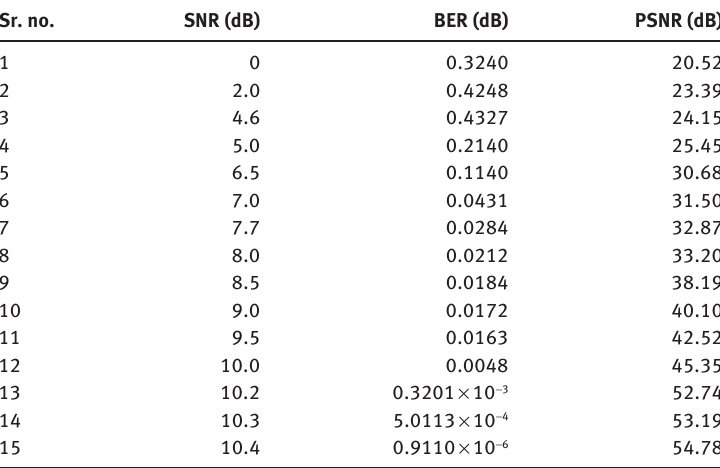
Table 2: BER and PSNR of the Received Host Image. Sr.